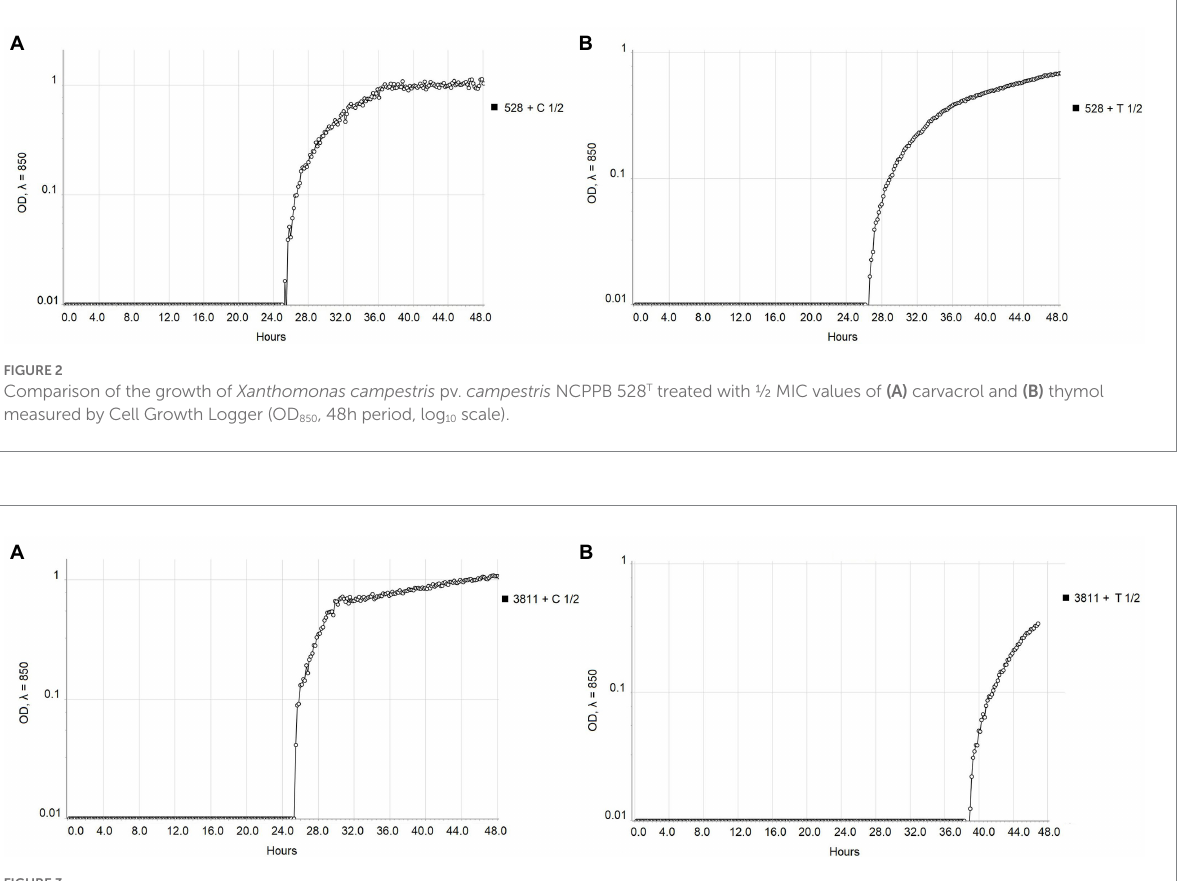
carvacrol and 0.3125% thymol solutions exhibited the in situ antibacterial activity against Xcc on cabbage seeds surface.